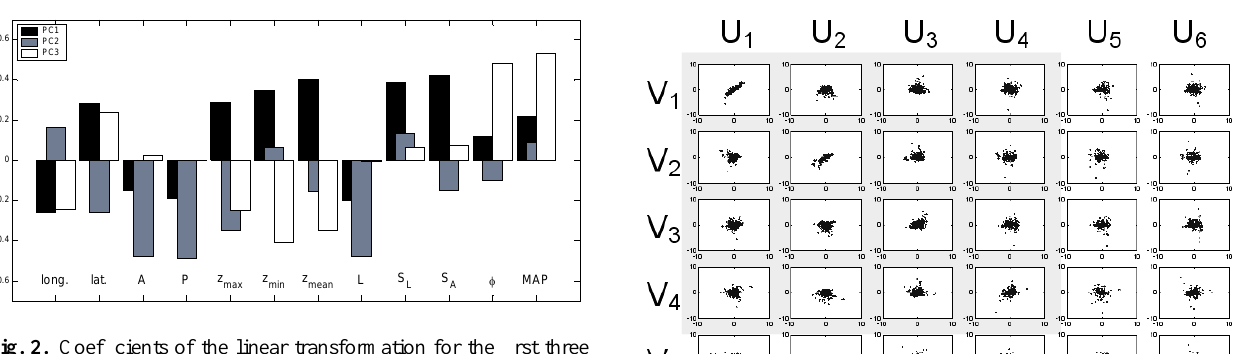
Fig. 2. Coefficients of the linear transformation for the first three PC’s of the X variables.